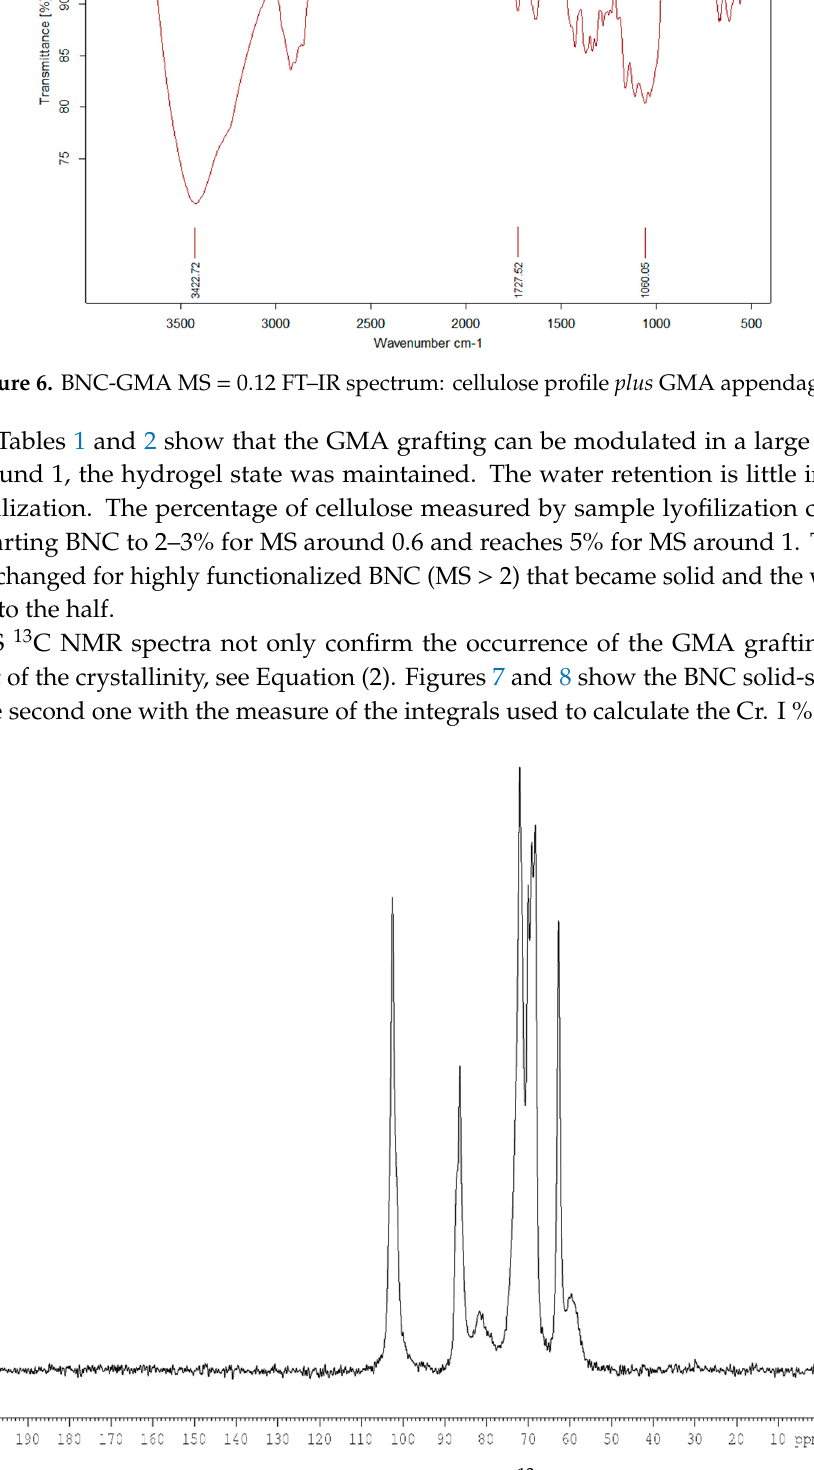
Figure 7. Cross-polarization magic-angle spinning (CP-MAS) 13 C nuclear magnetic resonance (NMR) of BNC: cellulose signals.